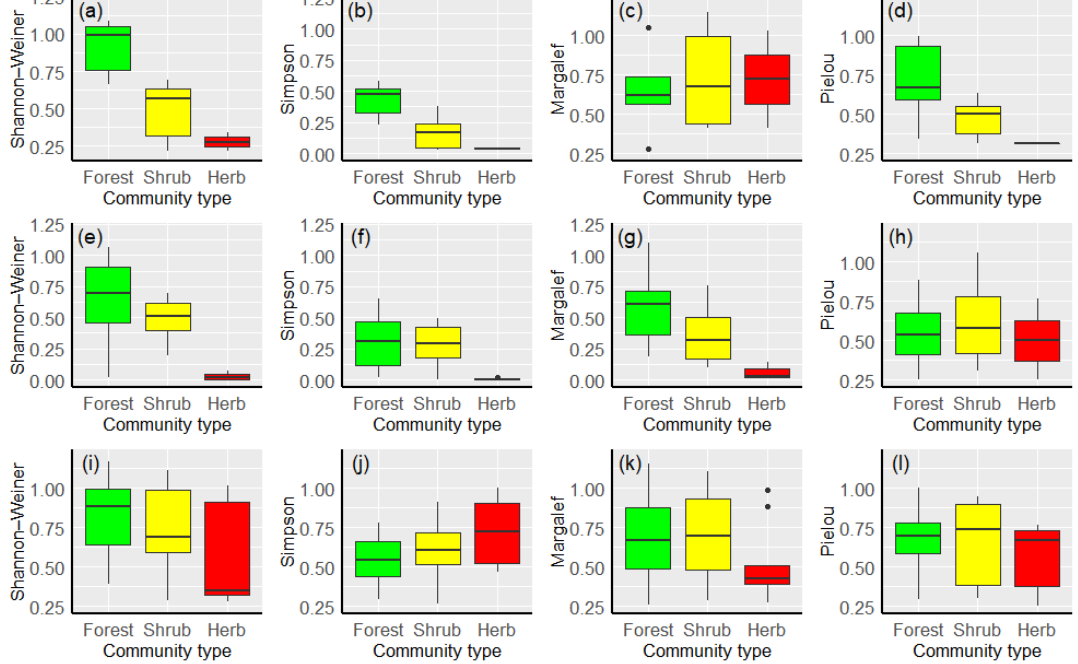
Figure 7. Changes in the Shannon–Weiner diversity index, Simpson diversity index, the Margalef richness index, and the Pielou evenness index for the different plant communities in 2000, 2010, and 2020; ( a – d ) represent 2000; ( e – h ) represent 2010; and ( i – l ) represent 2020.